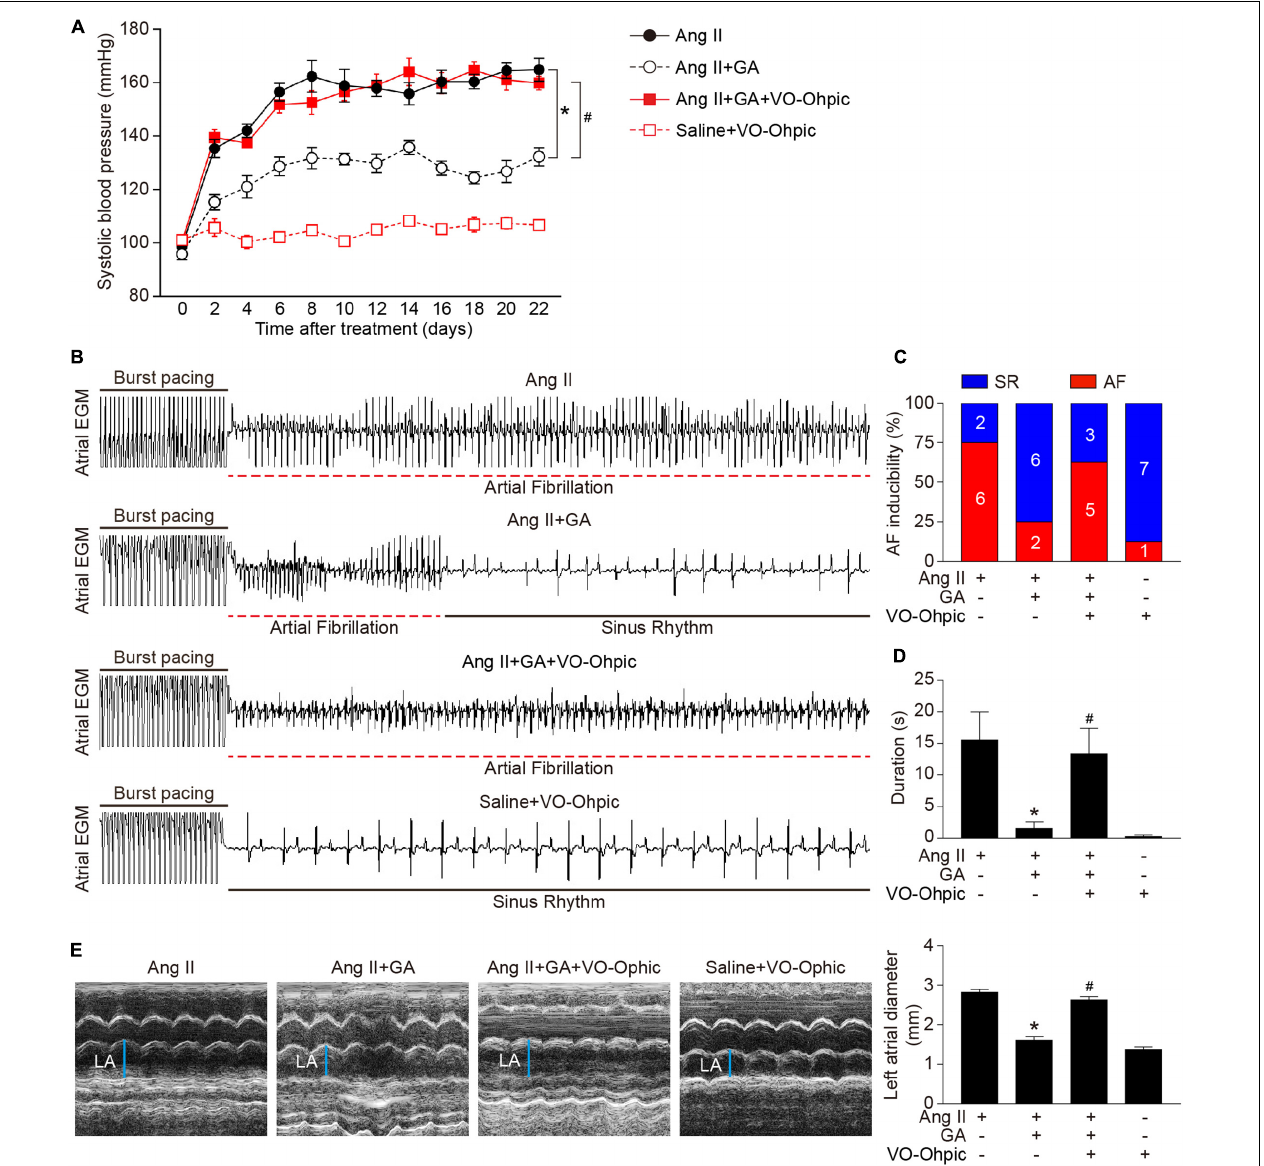
FIGURE 5 | Blocking of PTEN activity suppresses the GA-mediated beneficial effect on Ang II-induced AF. (A) SBP was measured by the non-invasive tail-cuff method in the vehicle or GA-treated mice before and after Ang II infusion with or without VO-OHpic treatment. (B) Representative atrial electrogram recordings. Burst pacing is highlighted by solid underlines, while dashed underlines indicate AF. (C) Percentage of mice in which AF was successfully achieved in each group ( n = 8). (D) AF duration in mice with AF induction. (E) M-mode echocardiography of LA chamber (left), and quantification of LA diameter (right, n = 8). * P < 0.05 versus Ang II, # P < 0.05 versus Ang II +